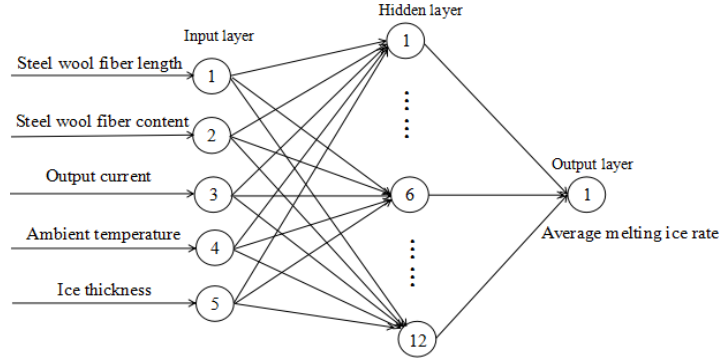
Figure 10. Diagram of BP neural network structure.